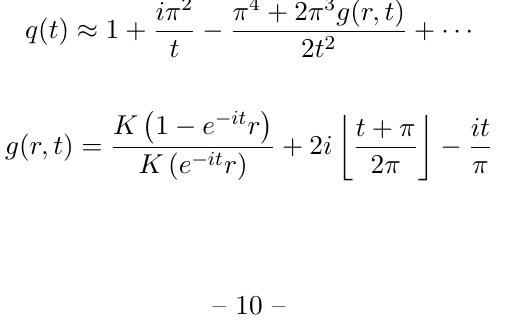
Figure 5 . These plots display the maximum of parameters. Convergence improves when h L and h H move closer to c= 24 and when c decreases. The intermediate primary dimension h seems to have little e(cid:11)ect on convergence. These plots de(cid:12)ne ‘convergence’